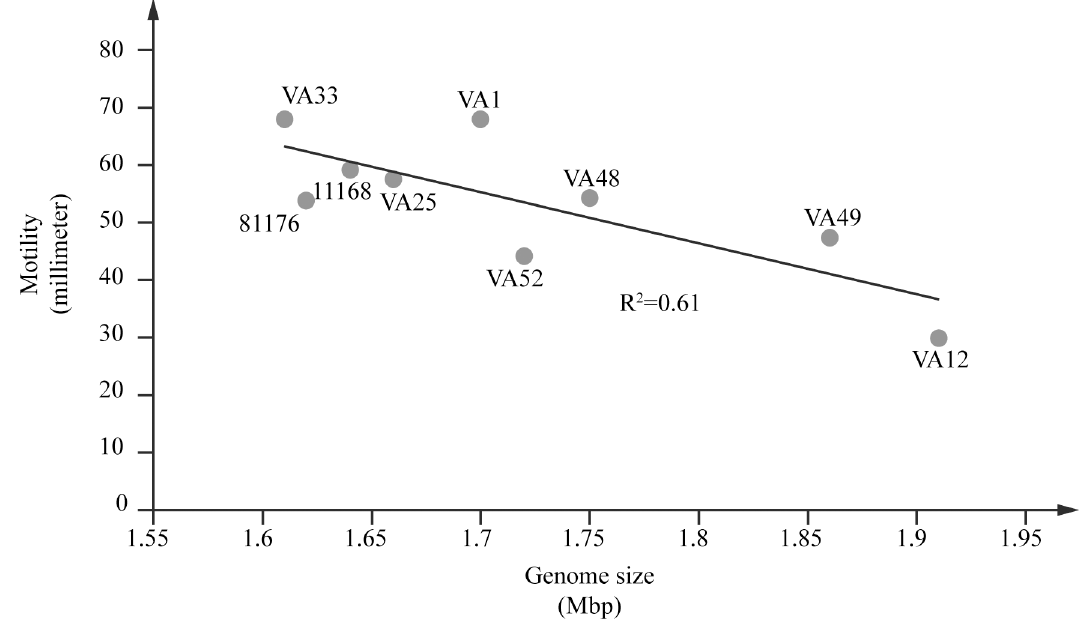
Fig 2. Motility and genome size of C . jejuni water isolates. Comparisonof motility and genome size of the seven C . jejuni water isolates. Plasmids are includedin the genomesize. C . jejuni reference strains 81–176and NCTC 11168 were includedfor